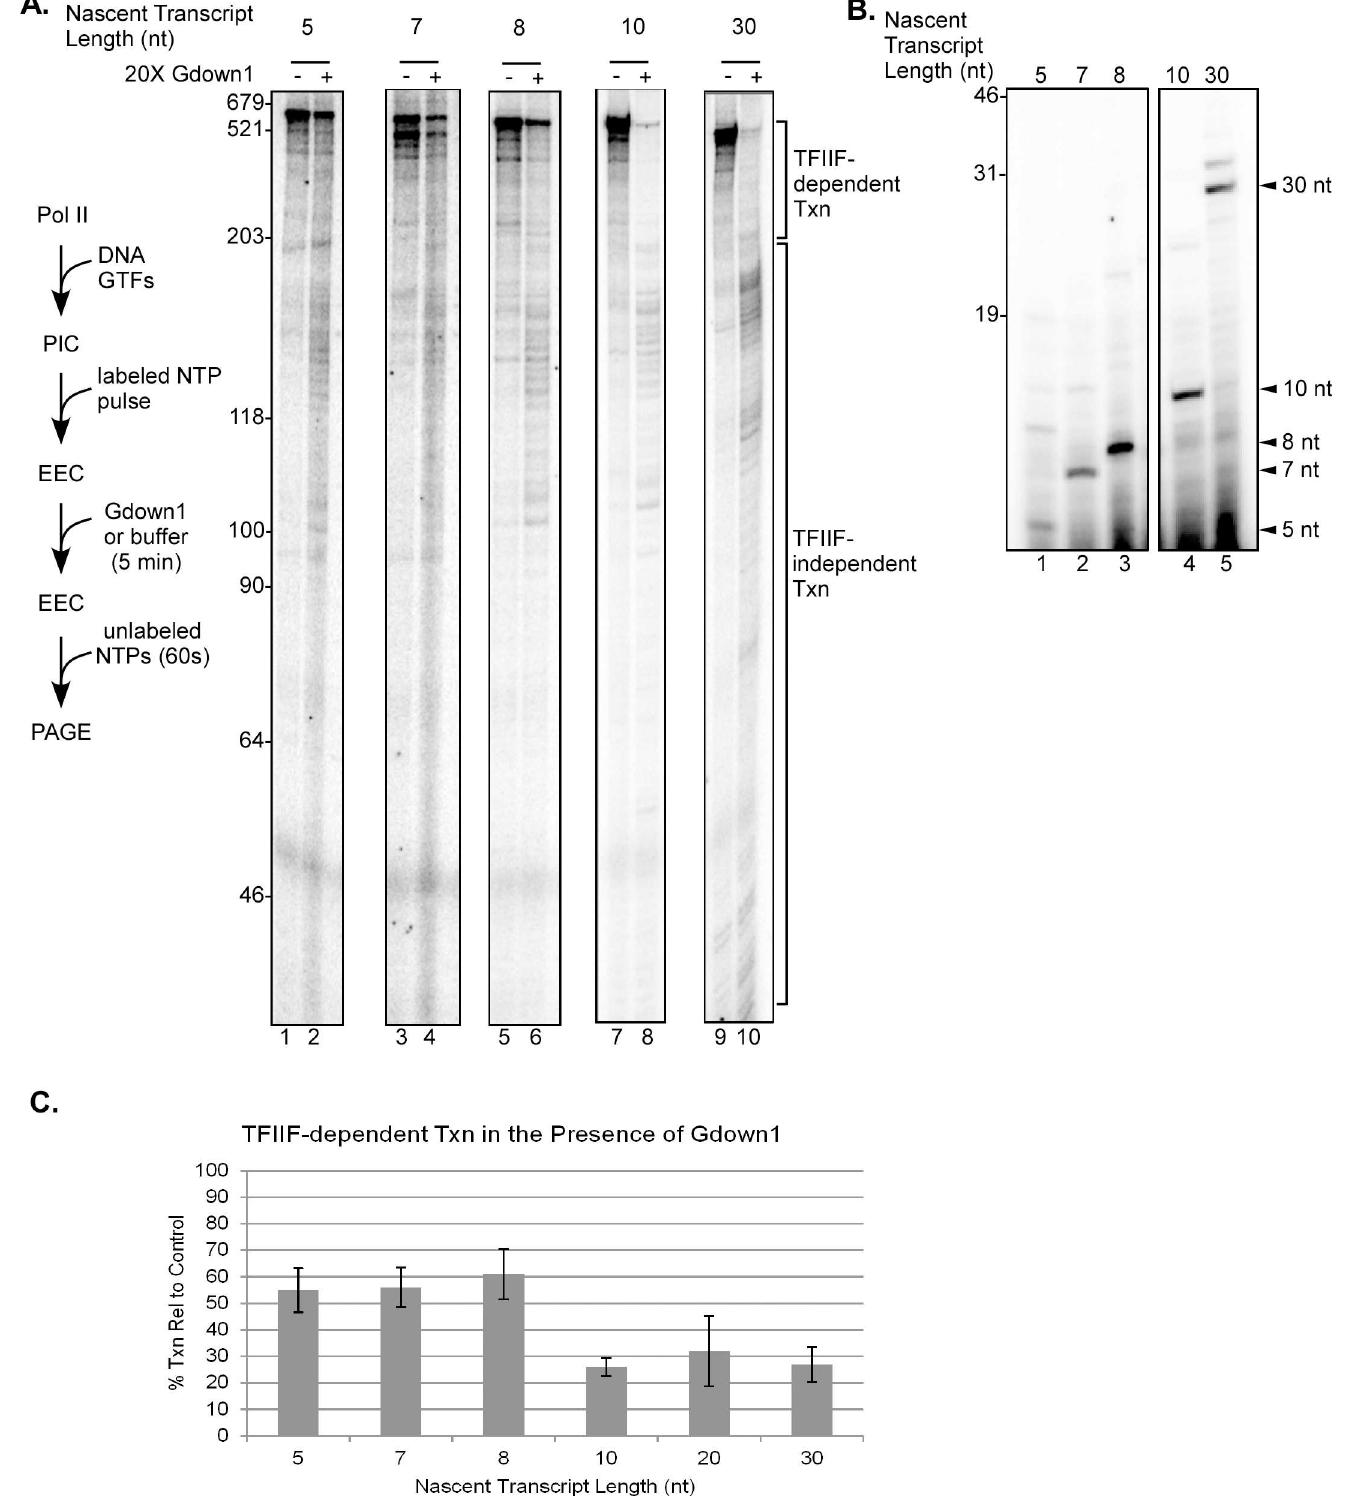
Fig 5. Efficiency of Gdown1 inhibition of TFIIF increases significantly with a 10 nt nascent RNA. (A) EECs were generated in solution on AdML 6g, 8g, 9g, 11g, and 31g(M) [19,30] templates with ATP, UTP and [ α - 32 P]CTP as describedin Materials and Methods. EECs were incubatedwith 240